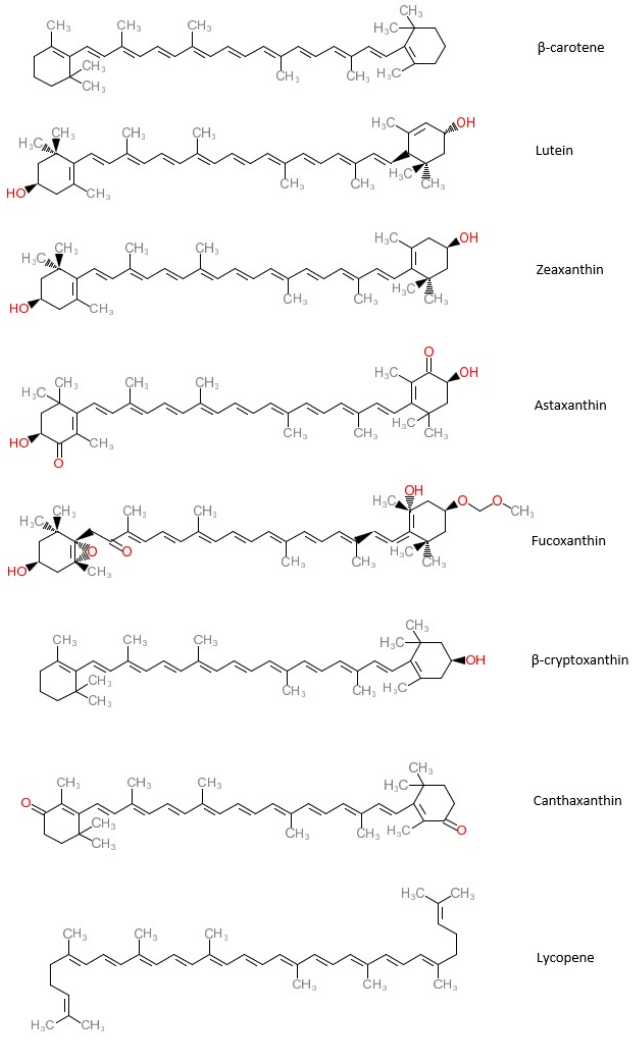
Figure 2. Chemical structures of the most common carotenoids.